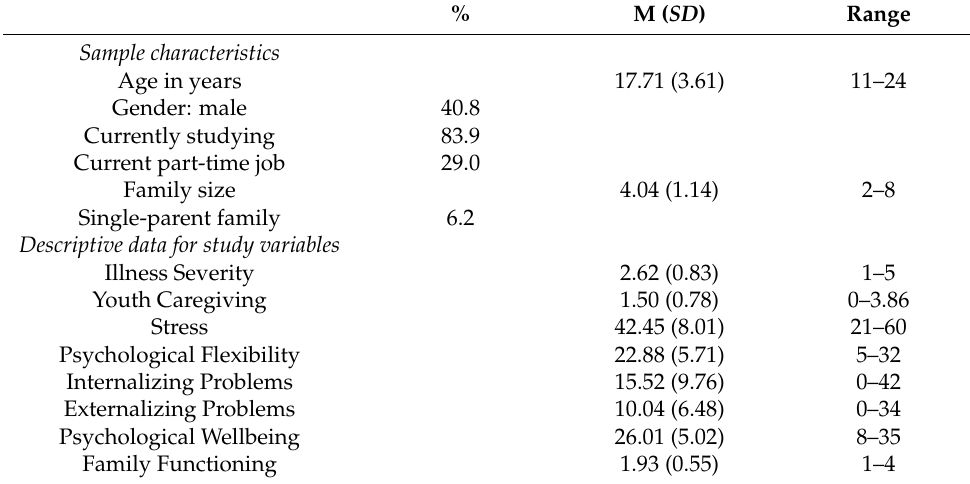
Table 1. Sample characteristics and descriptive data for the study variables (N = 387).